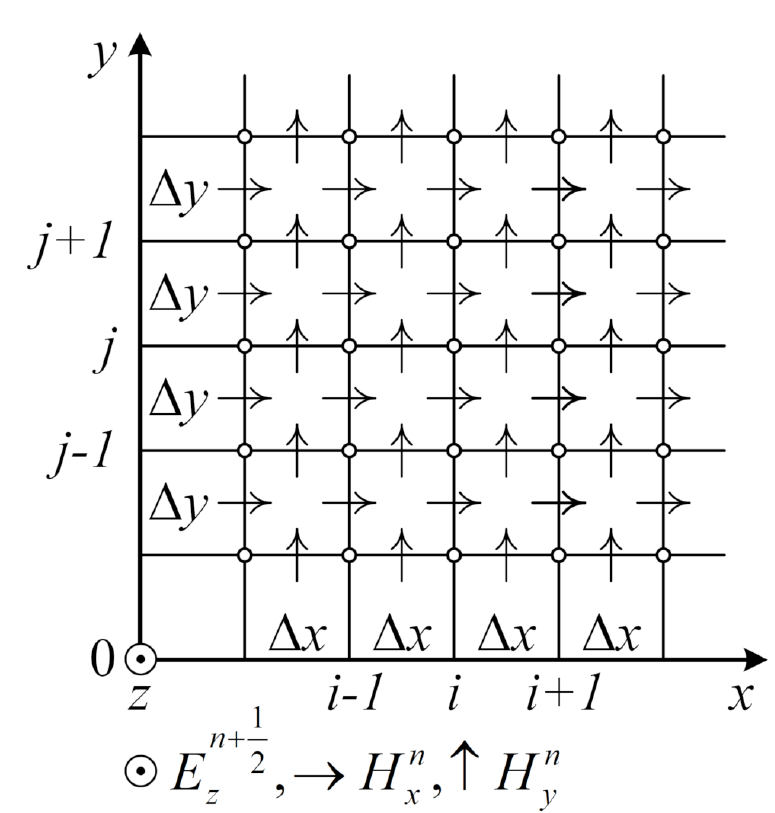
Figure 5. The schematic illustration of the functioning numerical algorithm in the FDTD method for evaluating the graphene